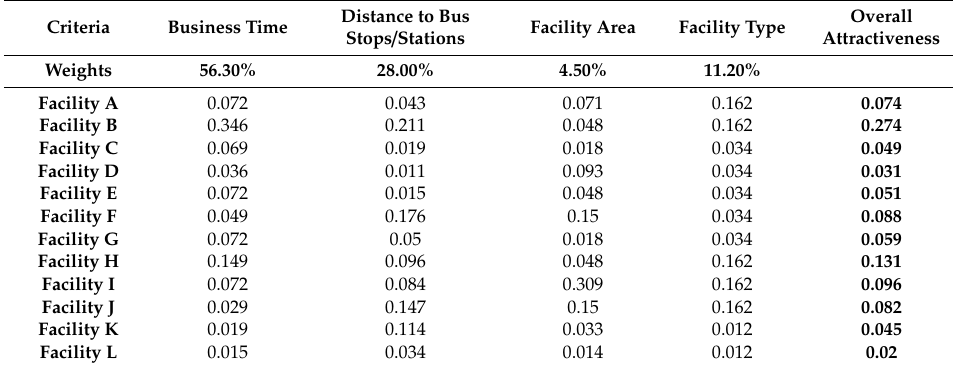
Table 6. The attractiveness of the alternatives.